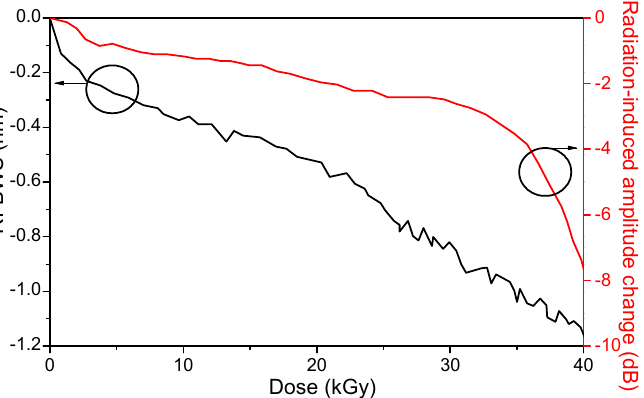
Figure 19. RI-BWS on the left (black curve) and peak amplitude reduction on the right (red curve) as a function of the dose, for an FBG written with an fs-laser in a CYTOP, under γ -rays. Data extracted from [38].